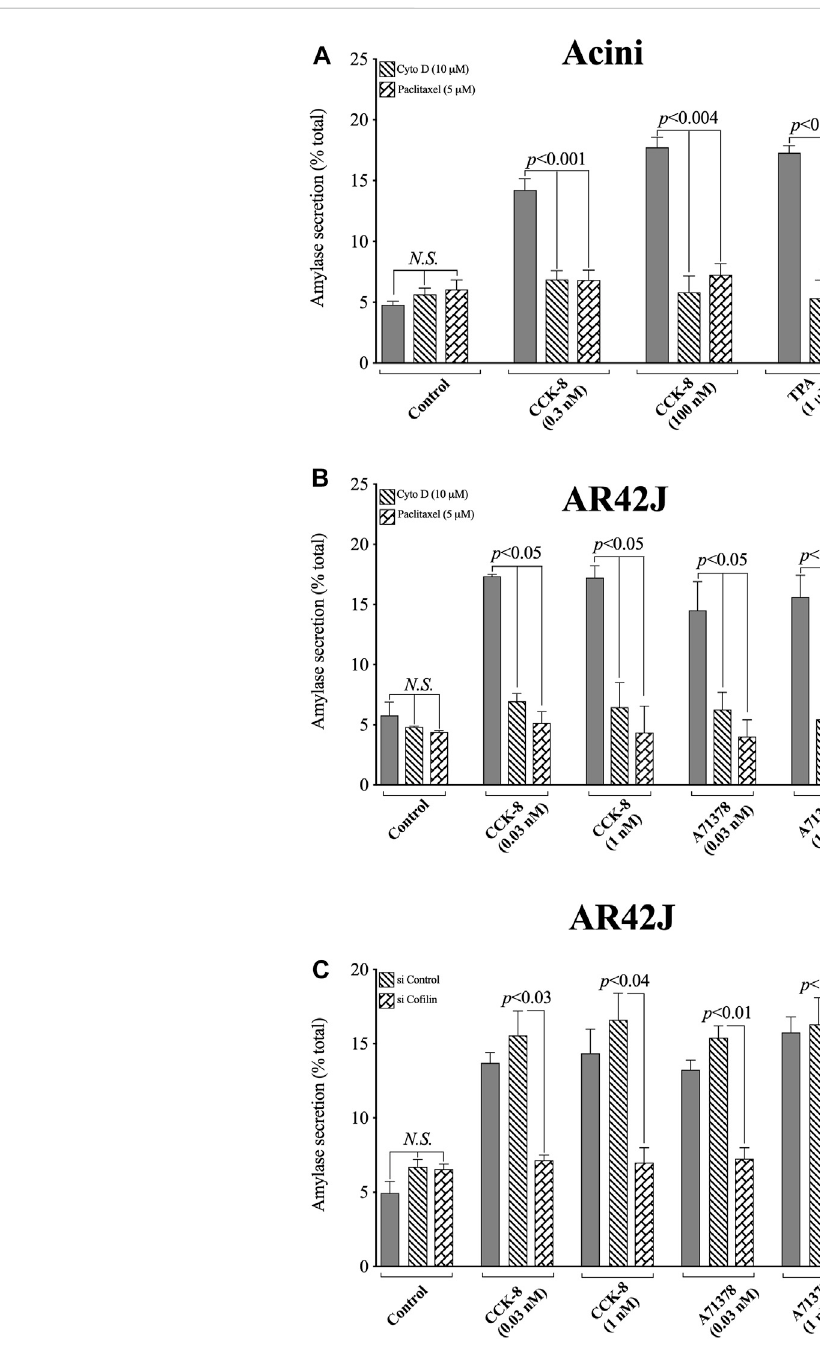
CCK 1 -R -transfected Panc1 cells, both SSH1 inhibitors, D3 and SE, completely inhibited the CCK-8-induced dephosphorylation of co fi lin, in contrast to a modest effect in acini (Figures 3C,D). Speci fi cally, SSH1 inhibitors, D3 and SE, completely abolished